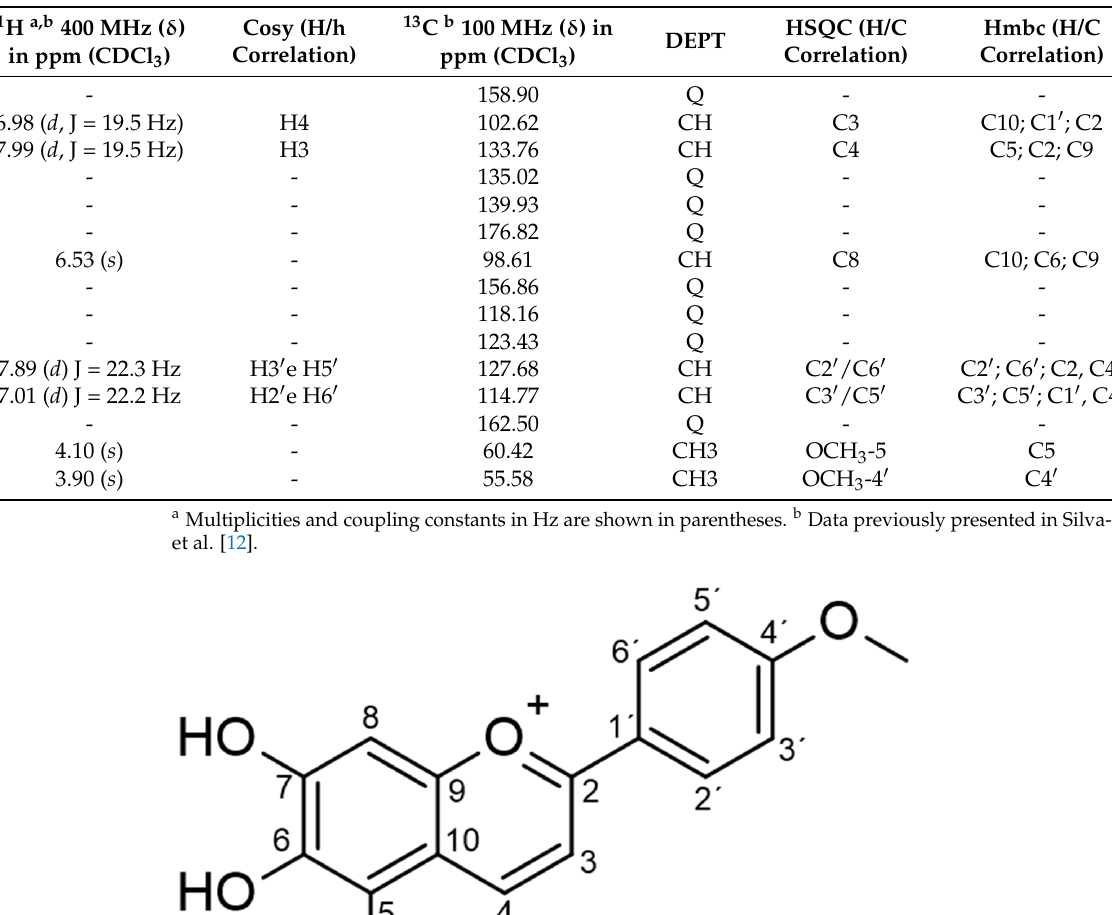
Table 1. NMR 1D and 2D data for carajurin.